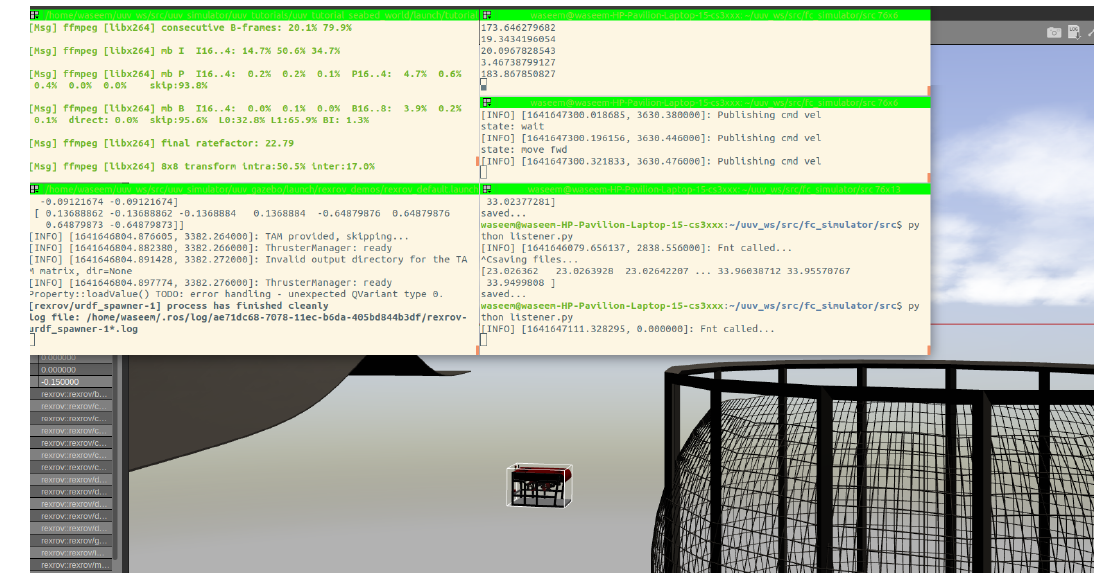
Figure 11. Simulation screen captured during